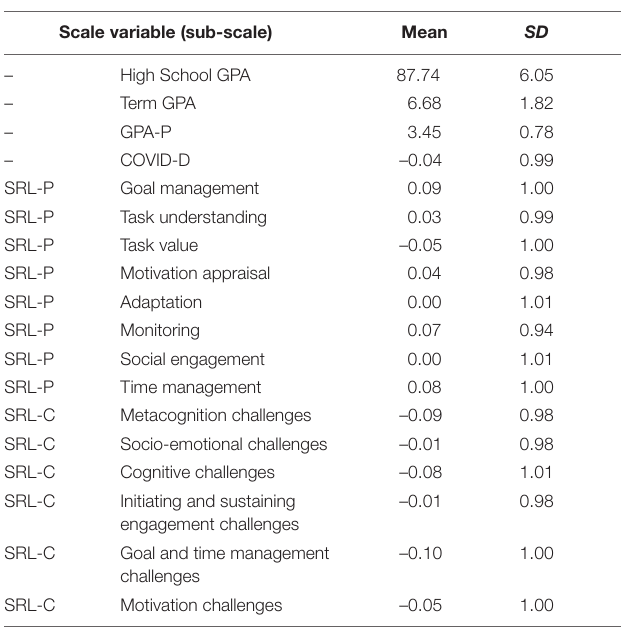
TABLE 1 | Descriptive statistics for the whole